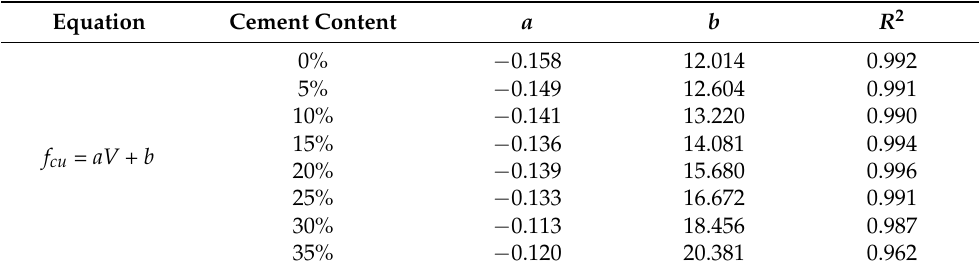
Table 6. The fitting results of the compressive strength ( f cu ) and foam volume ( V ). Equation Cement Content